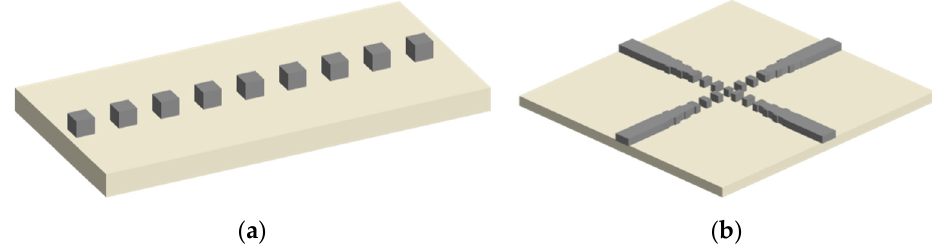
Figure 4. ( a ) Schematic of the sub-wavelength grating (SWG) silicon waveguide and ( b ) top view of SWGs silicon waveguide crossing with tapers .